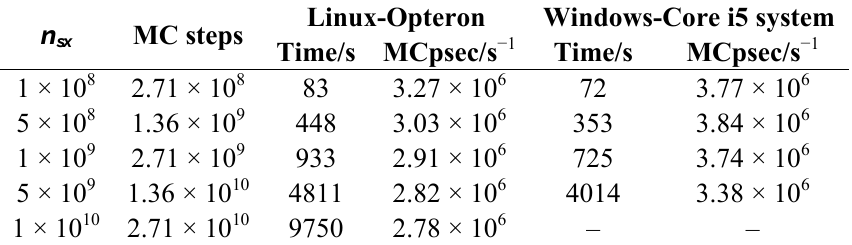
= [Cu I X/2L] = 0.08725 mol/L. 0 0